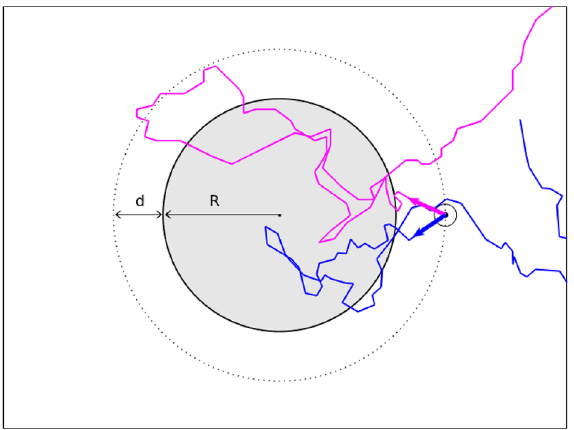
Figure 1. Schematic representation of the virtual medium. R e = d + R is the radius of the boundary source of animals. Two real trajectories (in pink and blue colours) are reported as